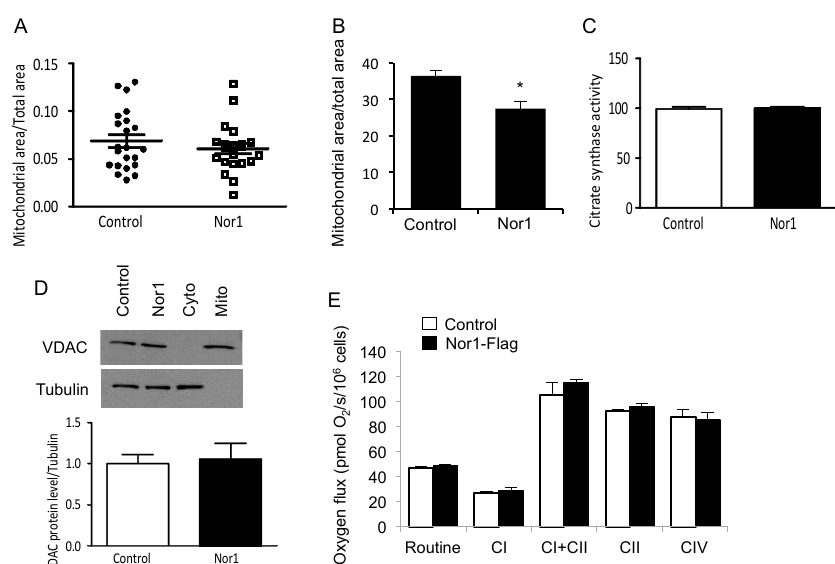
Figure 7. Nor1 and mitochondrial content in beta cells. ( A ) Relative mitochondrial area was determined from TEM images of INS832/13 cells transfected with Nor1-Flag or a control flag vector and normalized to total cell area. ( B ) Relative mitochondrial area was determined from fluorescence images of INS832/13 cells transfected with Nor1-GFP or a control GFP vector using Mitrotracker Red and normalized to total cell area. ( C ) Citrate synthase activity was measured in control cells (white bar) or cells overexpressing Nor1 (black bar) ( n = 4). ( D ) VDAC protein levels were measured by Western blot in INS cells transfected with Nor1-Flag or a control flag vector. Cytoplasmic (Cyto) and mitochondrial (Mito) fractions were used as negative and positive controls, respectively. Results were normalized to tubulin ( n = 5). ( E ) Sequential respiratory states in INS832 / 13 cells transfected with Nor1-Flag or a control vector ( n = 4). The protocol includes the following steps: Routine (basal respiratory state), Complex-I (CI; oxygen flux after addition of malate, pyruvate, and glutamate), CI + CII (after addition of succinate), CII (after inhibition of CI by rotenone), and CIV (after addition of TMPD and ascorbate). Respiration is expressed per million cells. All results are represented as mean ± SEM; *, p < 0.05 versus